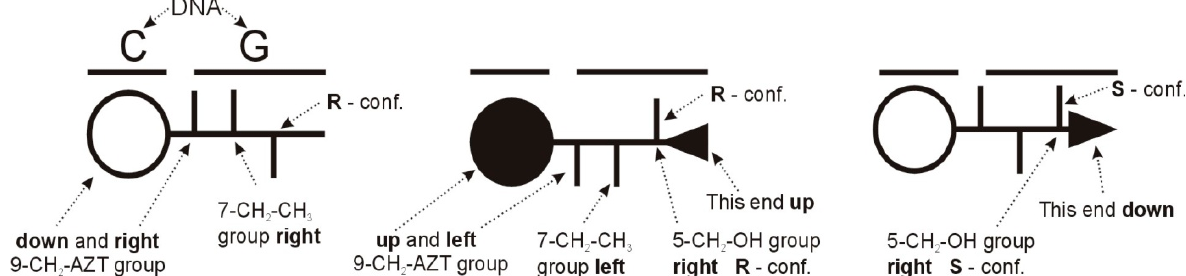
Figure 7. Schematic representation of the conformational geometries of diastereomers 1 and 2 vs. the ultimate base pair G1-C8.